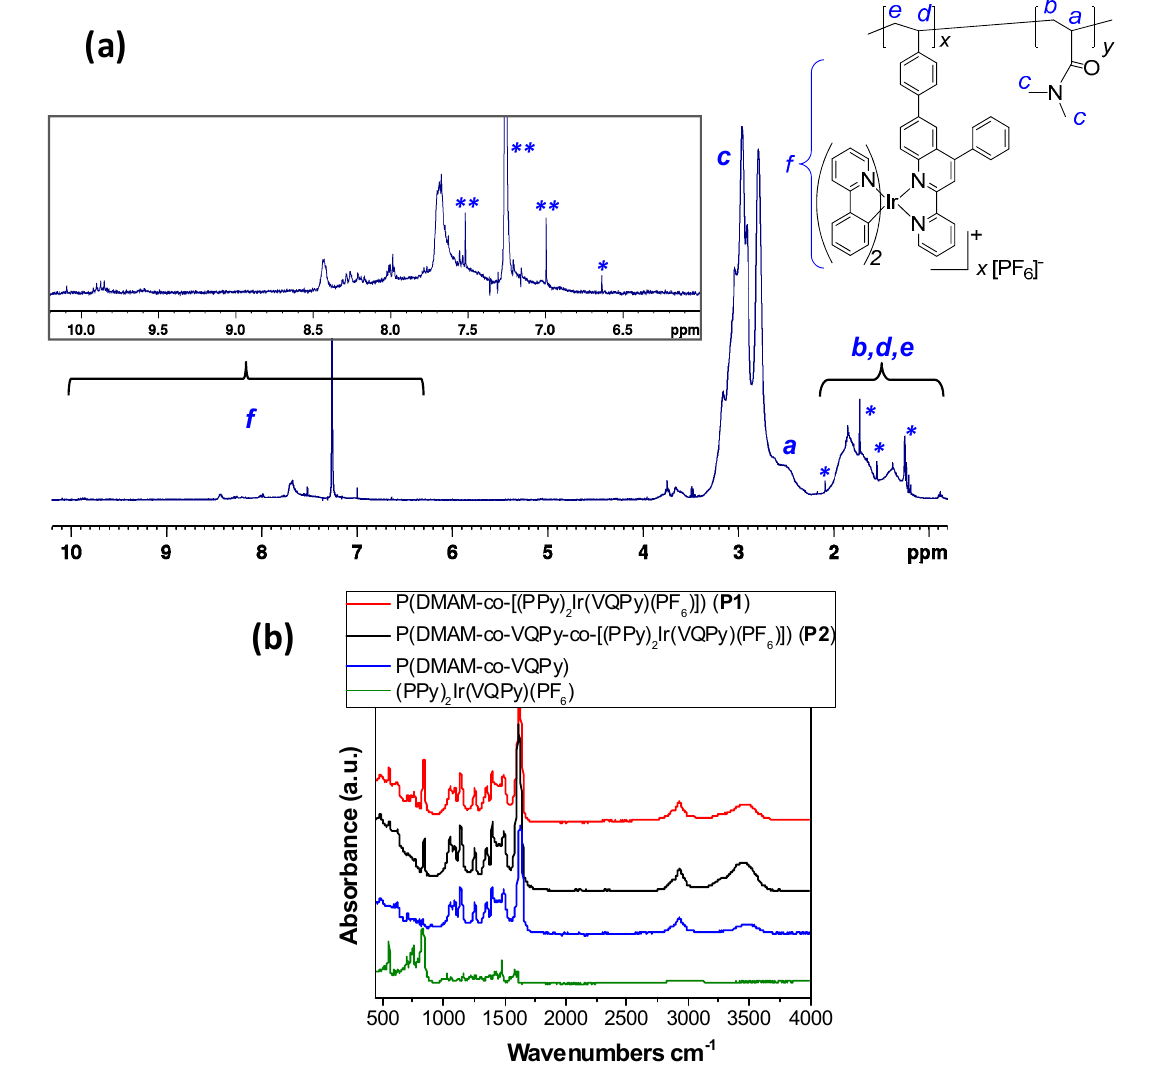
Figure 2. ( a ) 1 H NMR spectrum in CDCl 3 of the copolymer P(DMAM-co-[(PPy) 2 Ir(VQPy)(PF 6 )]) P1 and ( b ) ATR spectra of the copolymers P(DMAM-co-[(PPy) 2 Ir(VQPy)(PF 6 )]) P1, P(DMAM-co-VQPy-co-[(PPy) 2 Ir(VQPy)(PF 6 )]) P2 and P(DMAM-co-VQPy) and of the monomer complex [(PPy) 2 Ir(VQPy)(PF 6 )]. In ( a ) peaks denoted with ** asterisks are the residual CHCl 3 of CDCl 3 and its symmetric 13 C satellites peaks, while peaks denoted with * asterisk are residual solvent